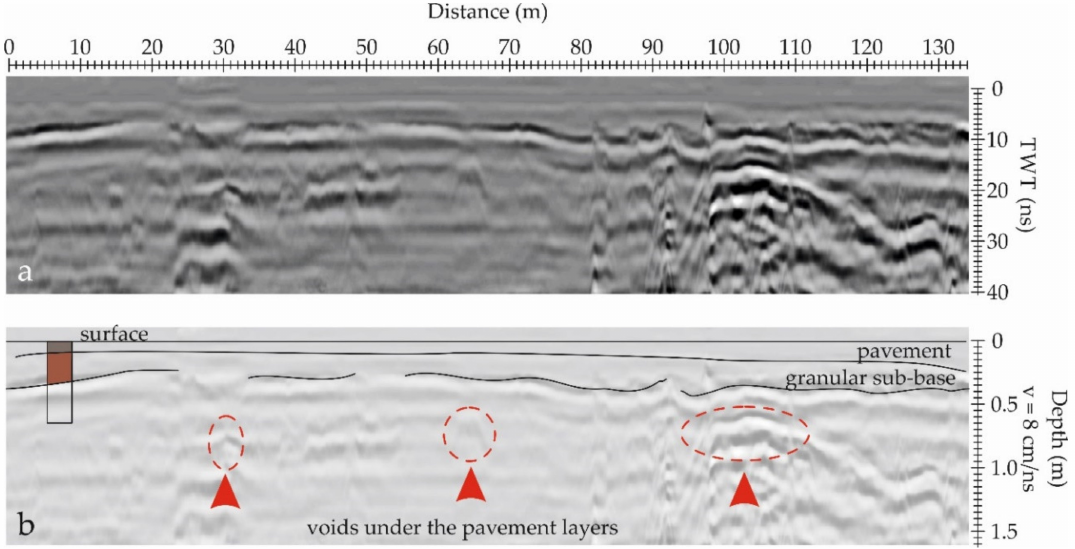
Figure 2. Detection of voids under the structure of the pavement with a 400 MHz center frequency antenna. Red arrows indicate the location of the anomalies associated to voids under the granular subbase, but the different layers of the pavement cannot be distinguished. ( a ) Radargram and ( b ) data